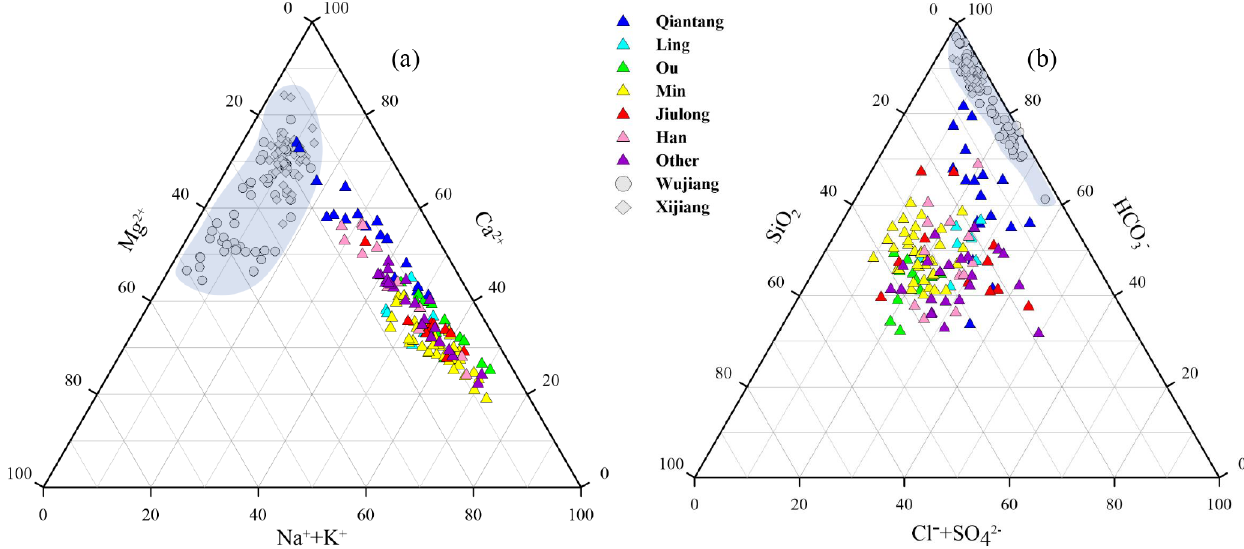
Figure 2. Ternary diagrams showing (a) cations, (b) anions and dissolved SiO 2 compositions of river water in the SECRB. Chemical compositions from case studies of rivers draining carbonate rocks (the Wujiang and the Xijiang) are also shown for comparison (data from Han and Liu, 2004; Xu and Liu 2007,